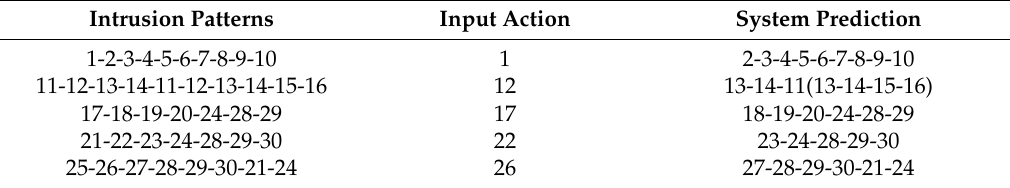
Table 4. Intrusion patterns for testing. The system makes predictions for input actions.